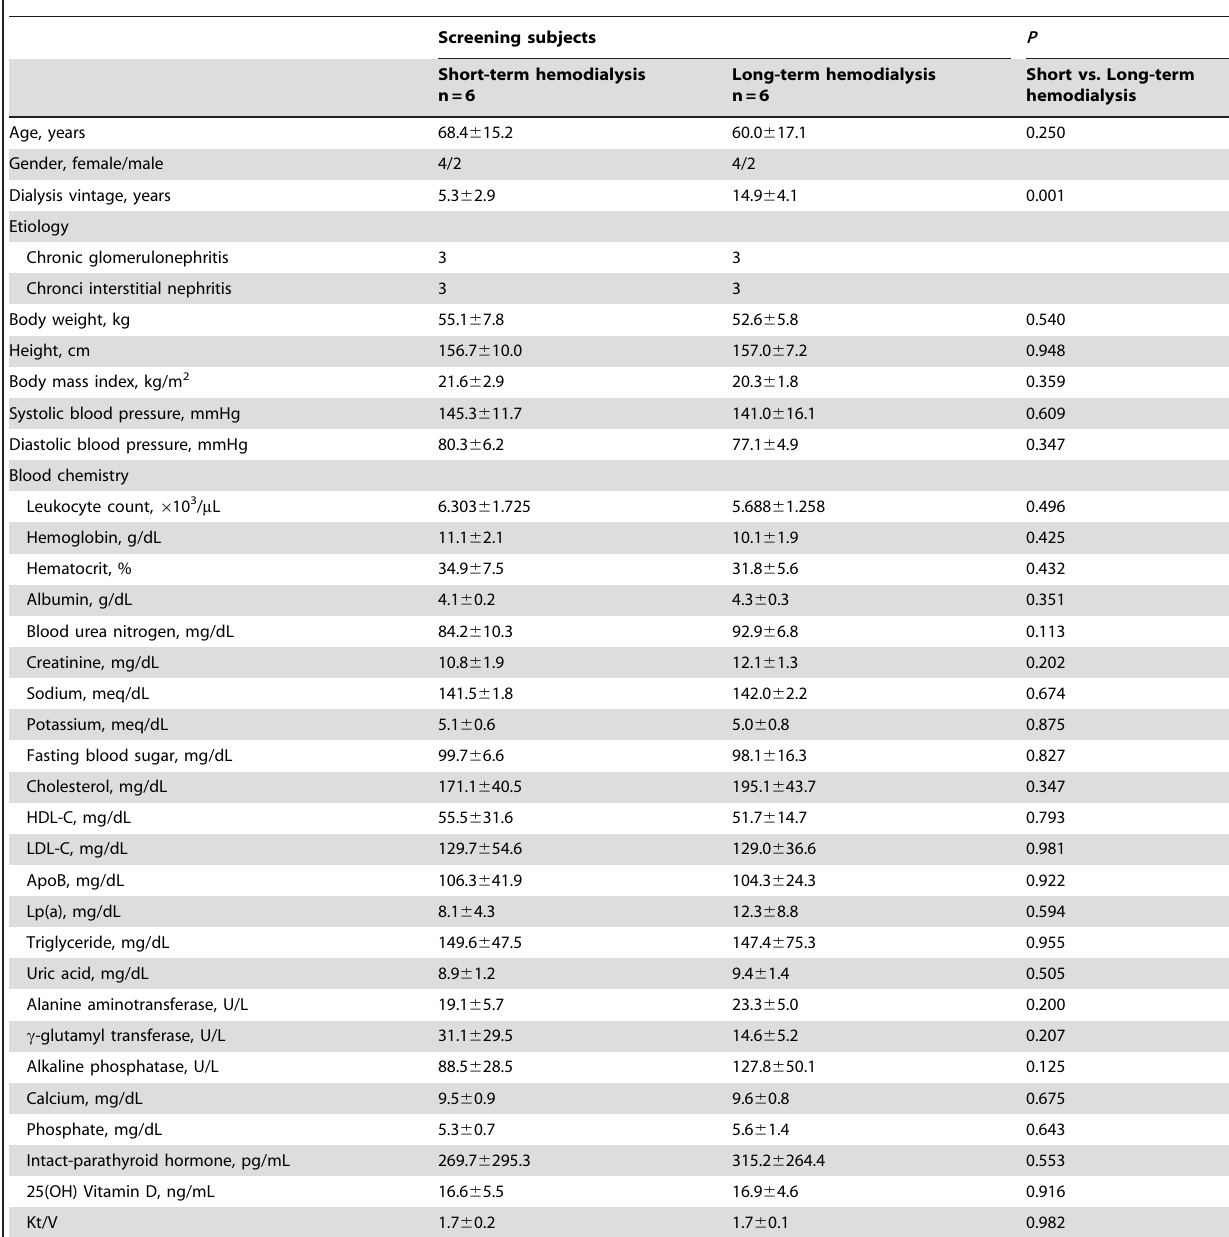
Table 1. Demographics and biochemistry of the studied HD population.